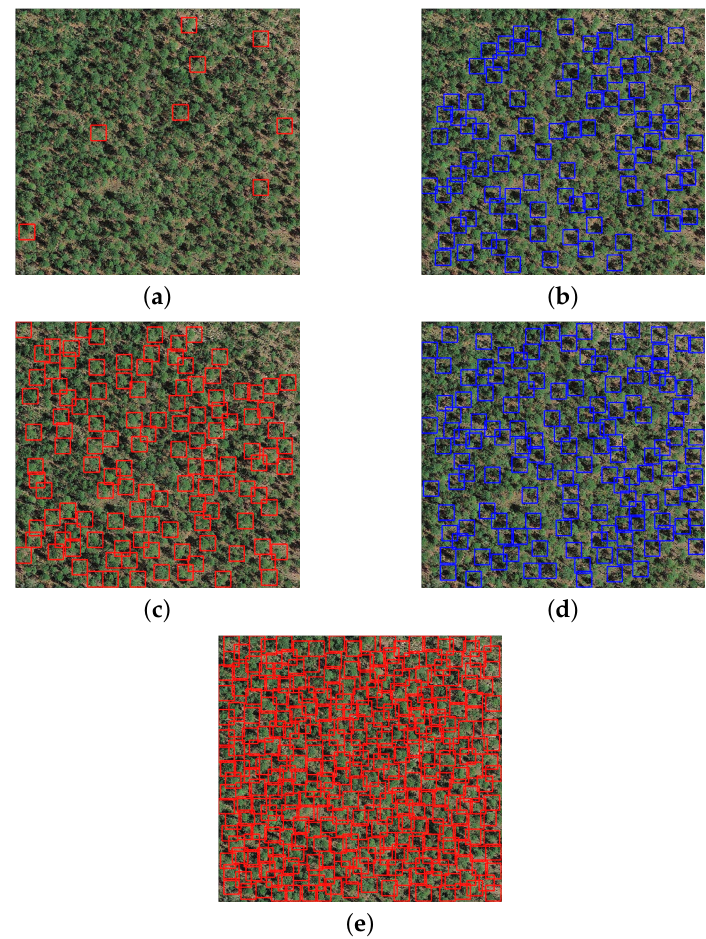
Figure 15. Results for different classification branches in Test Area 3 (window size 45 × 45): ( a ) Positive samples received in Branch 1; ( b ) Negative samples removed in Branch 1; ( c ) Positive samples received in Branch 2; ( d ) Negative samples removed in Branch 2; and ( e ) Positive samples received in Branch